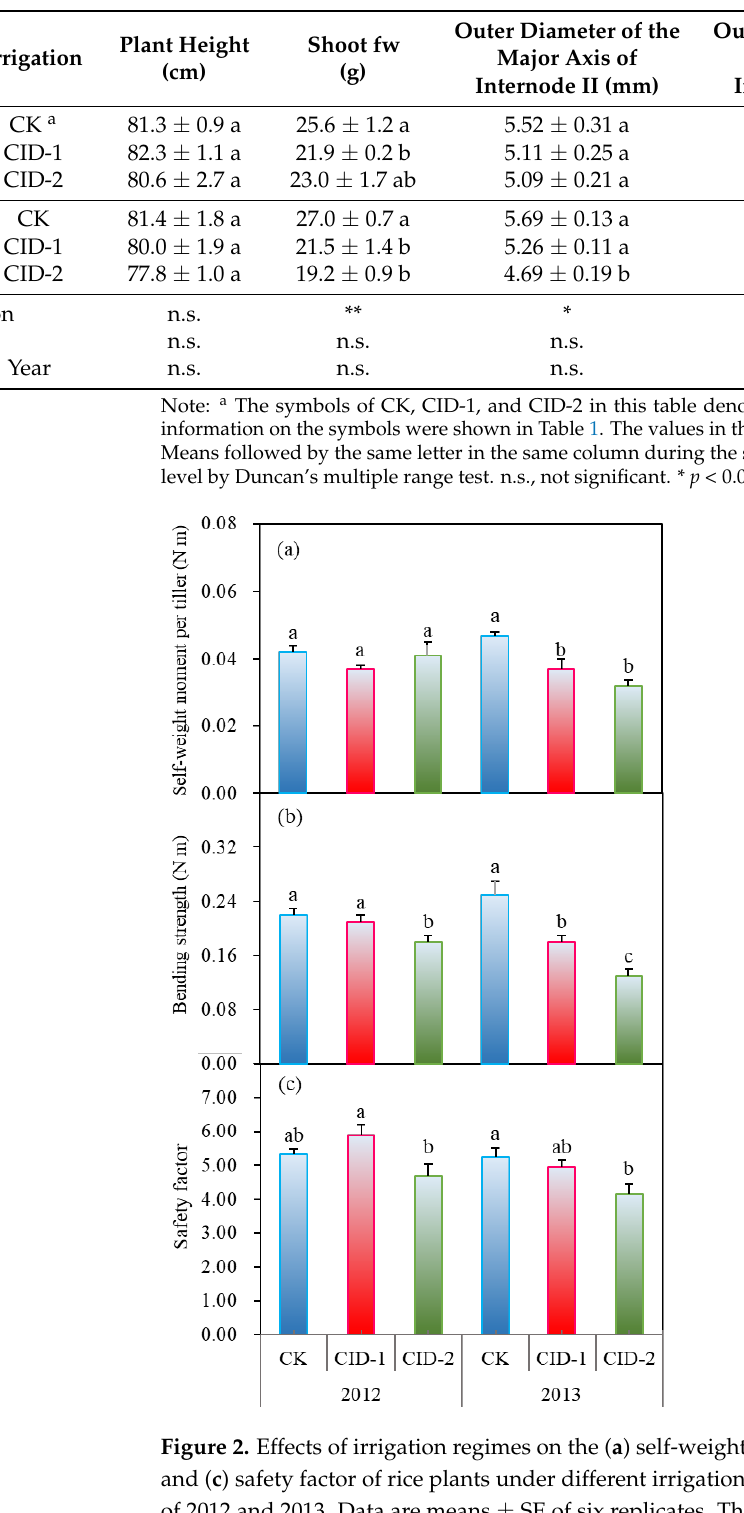
Table 2. The effects of treatments and output of two-way analysis of variance (ANOVA) for plant height, fresh weight (FW) of shoot, outer diameter (OD) of major and minor axis of internode II, and length of internode II of rice plants under different irrigation regimes during the rice-growing season of 2012 and 2013.